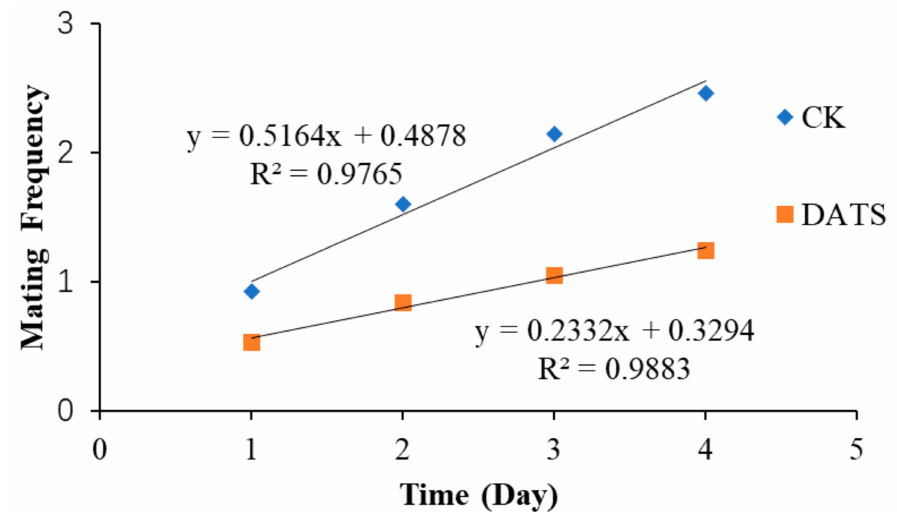
Figure 3. E ff ects of diallyl trisulfide (DATS) on the mating frequency of Sitotroga cerealella compared with the control (CK). The slope of each line was compared using a covariance analysis, Degree of freedom (Df) = 2, F = 22.921, p =